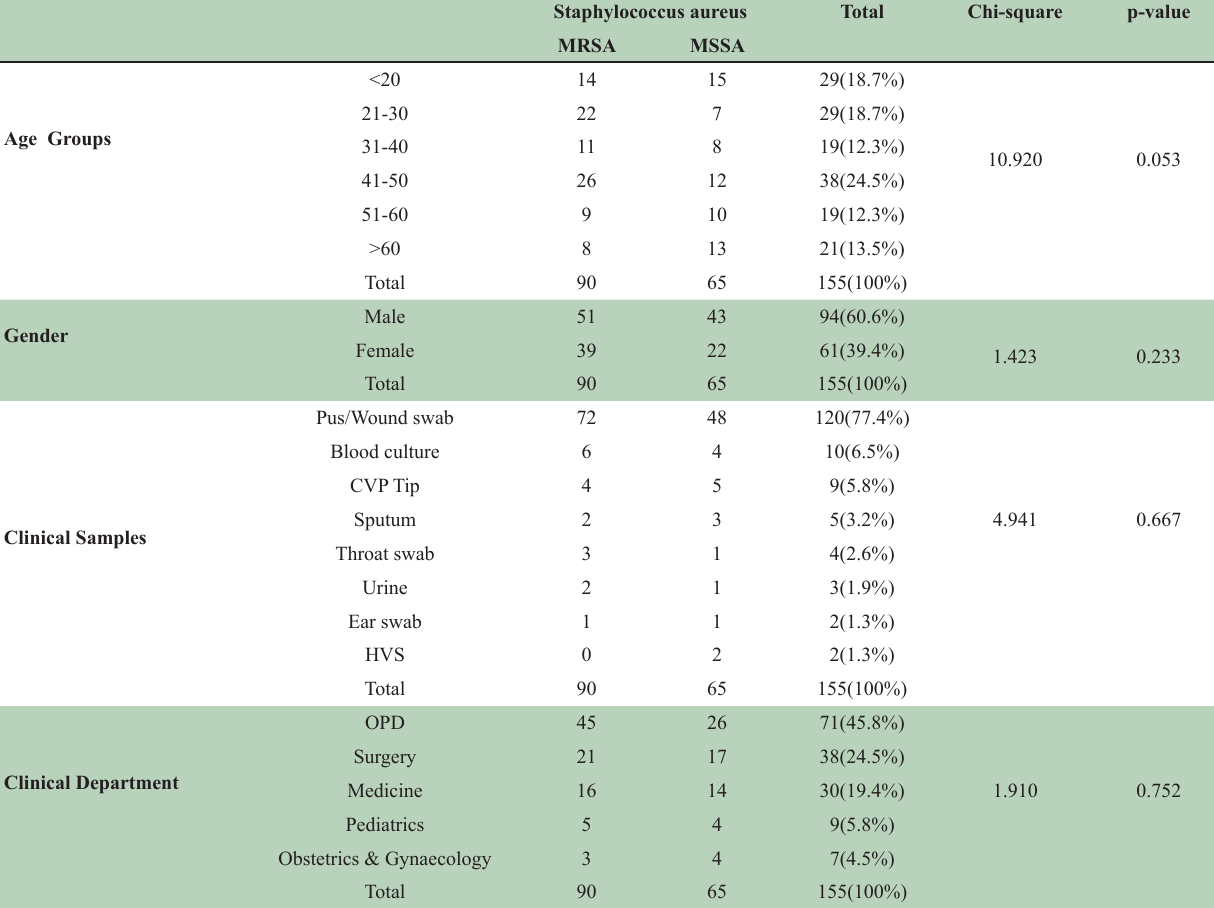
Table-I: Distribution of MRSA and MSSA according to Demographic Profile.